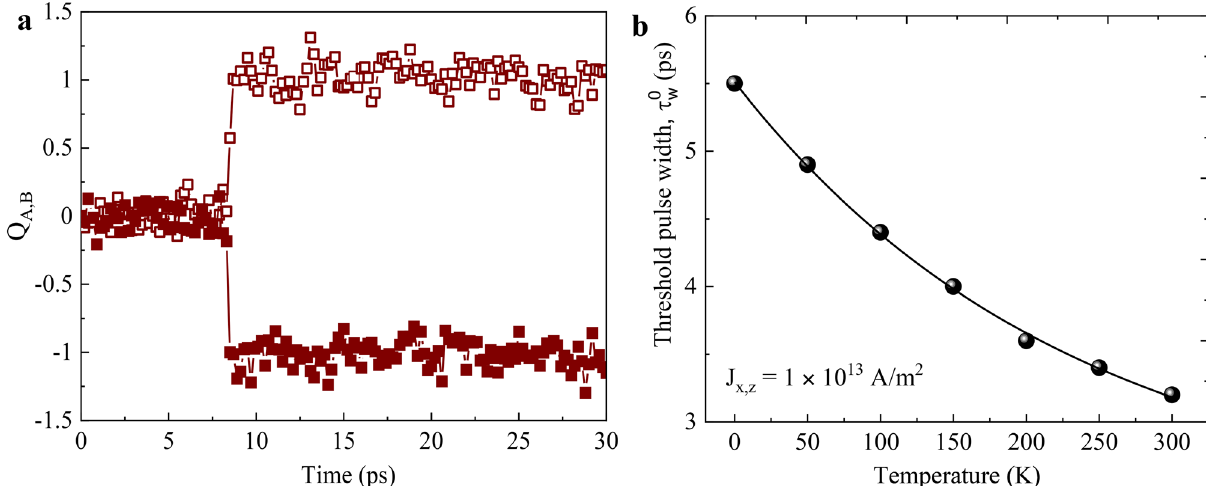
Figure 5. ( a ) Time evolution of topological charge at ( T (closed symbols) of the AFM skyrmion. ( b ) Variation of threshold pulse width on the temperature at fixed 1 10 13 A/m 2 current density ( J x , z = ×